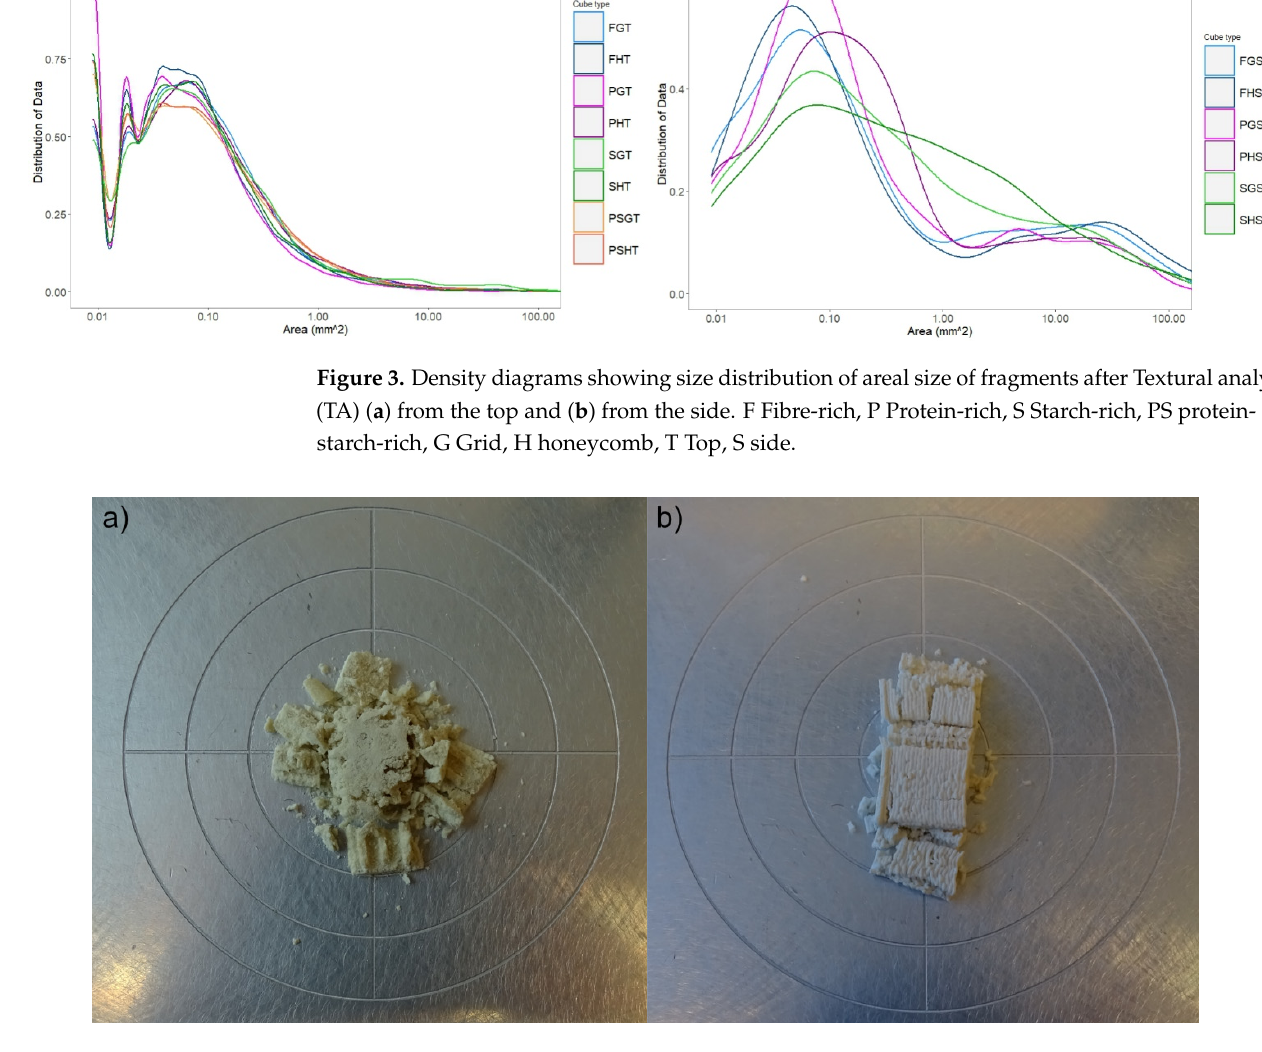
Figure 4. Images of the two samples that differed most after compression: ( a ) protein-rich recipe with grid infill pattern compressed from the top (PGT) and ( b ) starch-rich recipe with honeycomb infill pattern compressed from the side (SHS).